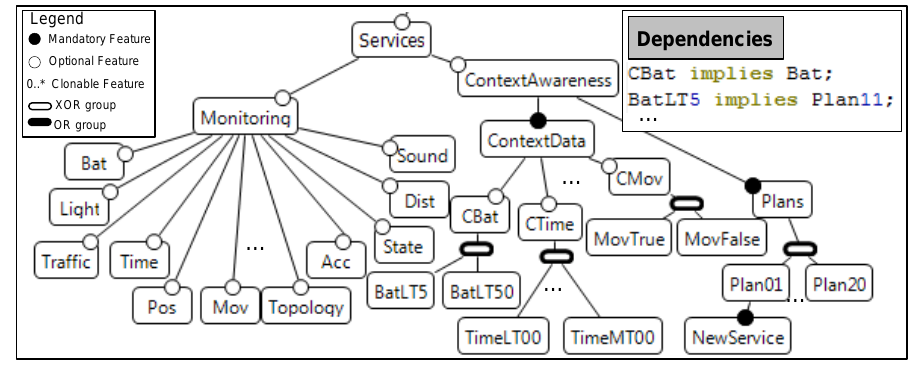
Figure 4. Partial FamiWare feature model of monitoring and context-awareness